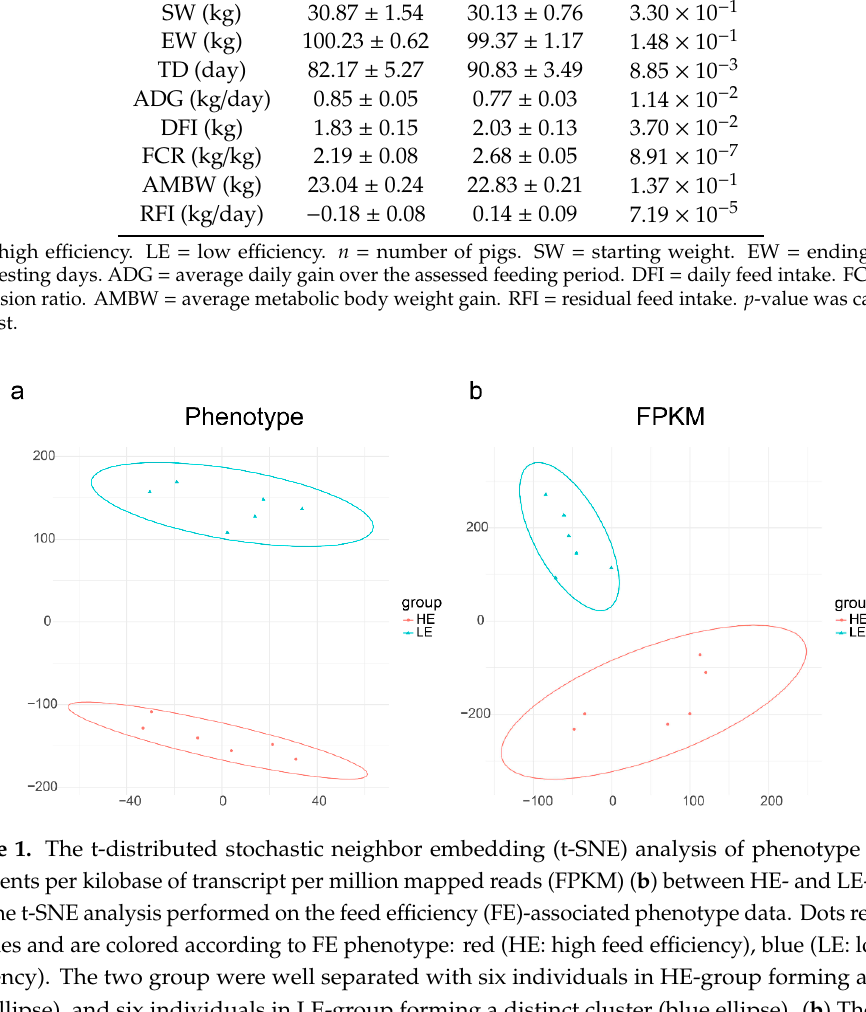
Table 1. Performance of Duroc × (Landrace × Yorkshire) (DLY) pigs used in transcriptome sequencing. Trait HE ( n = 6) LE ( n = 6) p -value